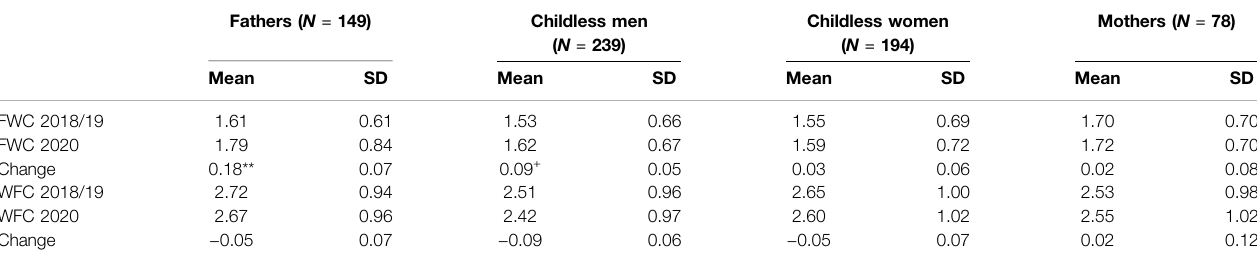
TABLE 4 | Descriptive statistics intersection gender and